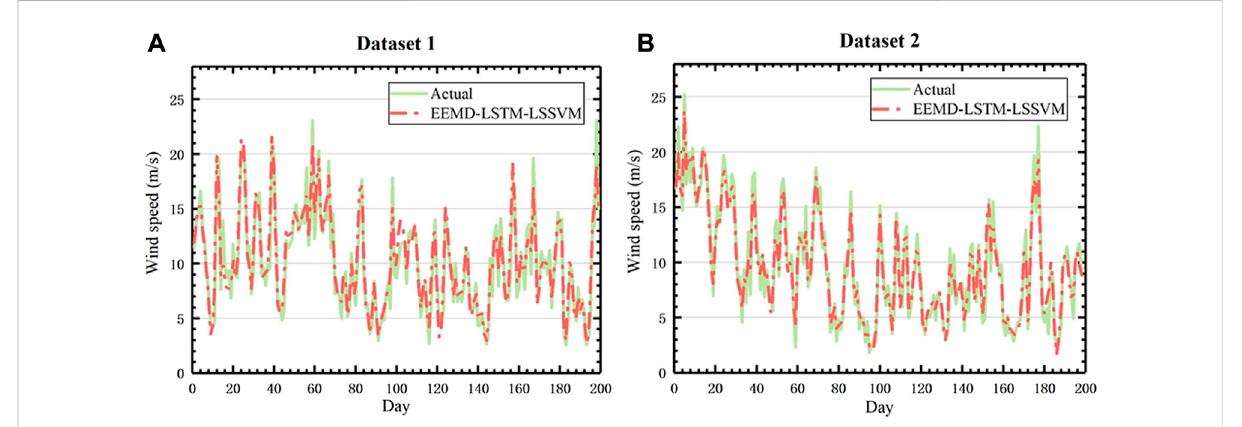
FIGURE 6 Predicted results obtained by EEMD-LSTM-LSSVM (A) Dataset 1. (B) Dataset 2.